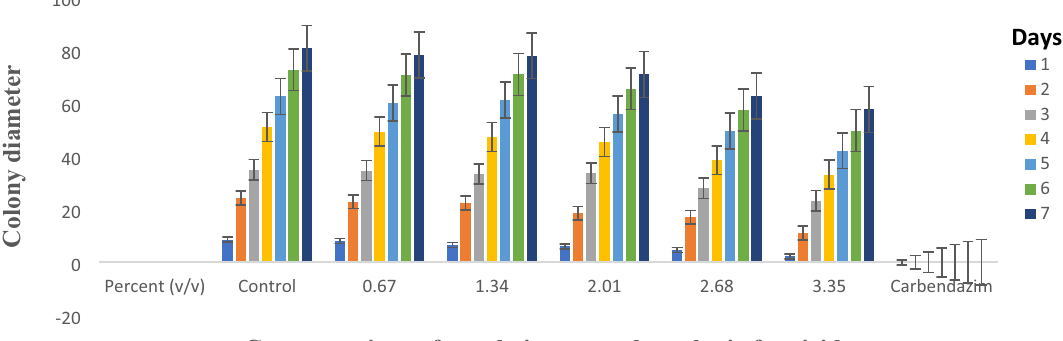
Figure 6. Average daily growth rate of Pestalotiopsis species on different concentrations of wood vinegar and Carbendazim